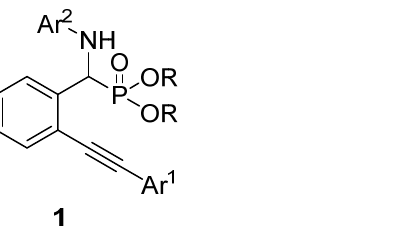
Figure 1. General formula of α -amino (2-alkynylphenyl)-methylphosphonates ( 1 ) and 1,2-dihydroisoquinolin-1-ylphosphonates ( 2 ).